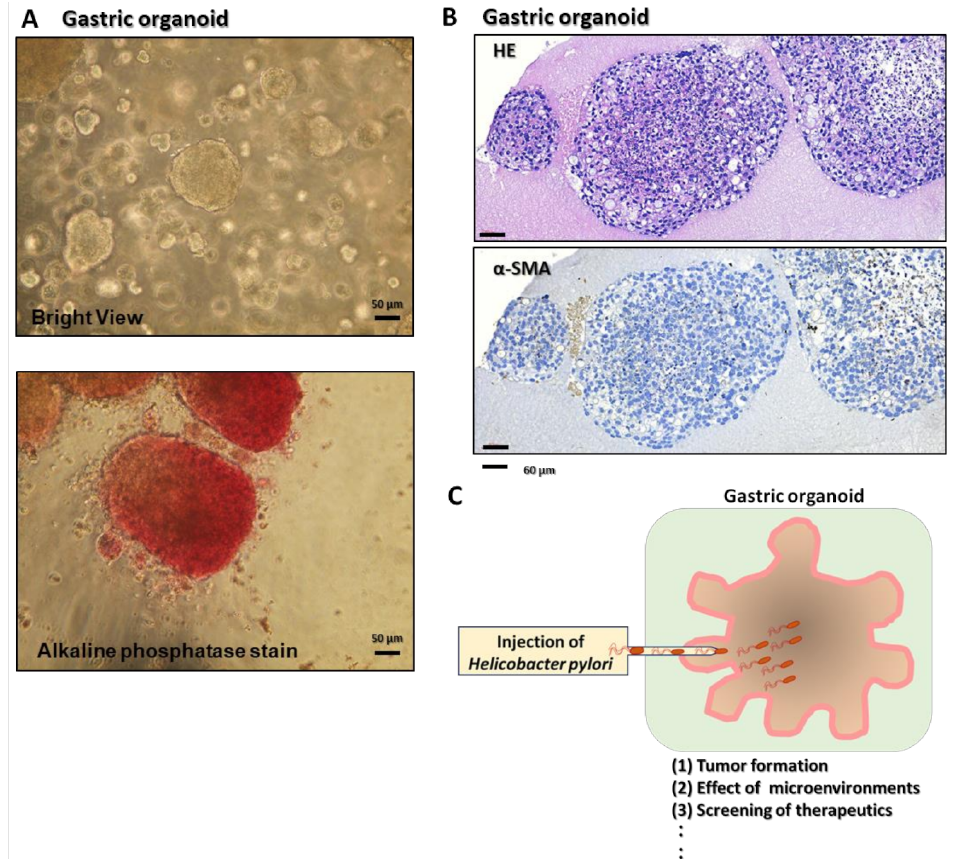
Figure 4. Alkaline phosphatase staining and immunohistochemistry of gastric organoids in matrigel- containing 3D cultures. ( A ) Bright-field view of an adenocarcinoma from human stomach-derived organoid lines (upper panel). HCM-BROD-0208-C16 cancer model primary adenocarcinoma cells of the stomach were cultured using a recommended American Type Culture collection protocol [6]. The stomach organoids were generated by seeding in 96-well plates and grown for 2 days ( n = 6). The organoids were fixed with 4% paraformaldehyde, and incubated with alkaline phosphatase detection reagents (SCR004, Millipore, Merck KGaA, Darmstadt, Germany). Positive alkaline phosphatase staining, a characteristic stem cell feature, is shown in red (lower panel). Scale bars = 50 µ m. ( B ) Gastric organoids at the maturation stage were generated in regular matrigel-containing 3D culture, and gastric organoids were verified by hematoxylin and eosin staining (upper panel). Alpha- smooth muscle actin (lower panel) was used as a marker of pericryptal myofibroblasts in gastric cancers. Scale bars = 60 µ m. ( C ) Schematic model of proposed experiments using the gastric organoids injected by H. p . are presented. (1), (2), (3),–; these functions will be